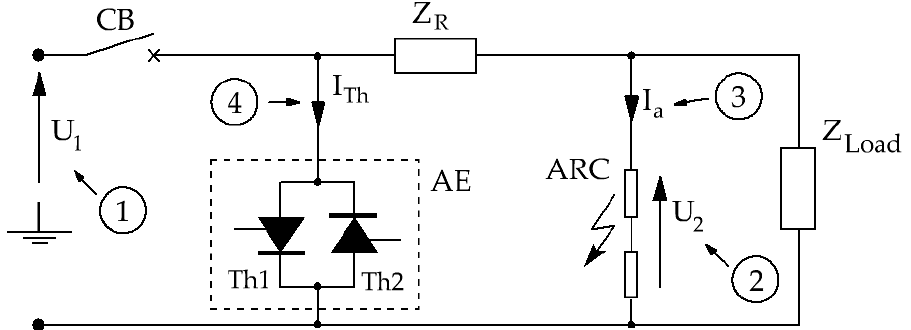
Figure 3. Part of the arc eliminator test circuit (AE) with marked measurement points: 1—supply voltage ( U 1 ), 2—voltage on the electrodes of the arc source ( U 2 ) , 3—current in the branch of the arc source ( I a ) , 4—current in the thyristor branch ( I Th ).